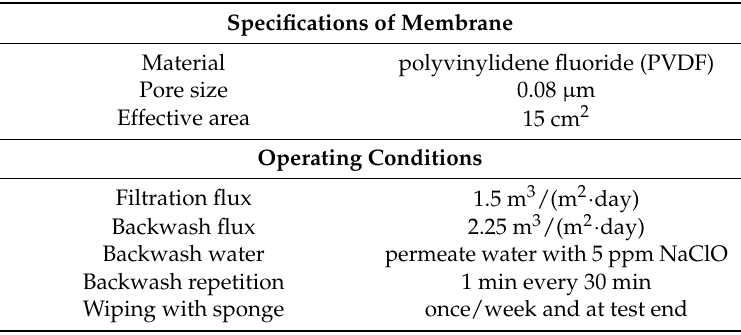
Table 1. Specification of the MF mini module and operating